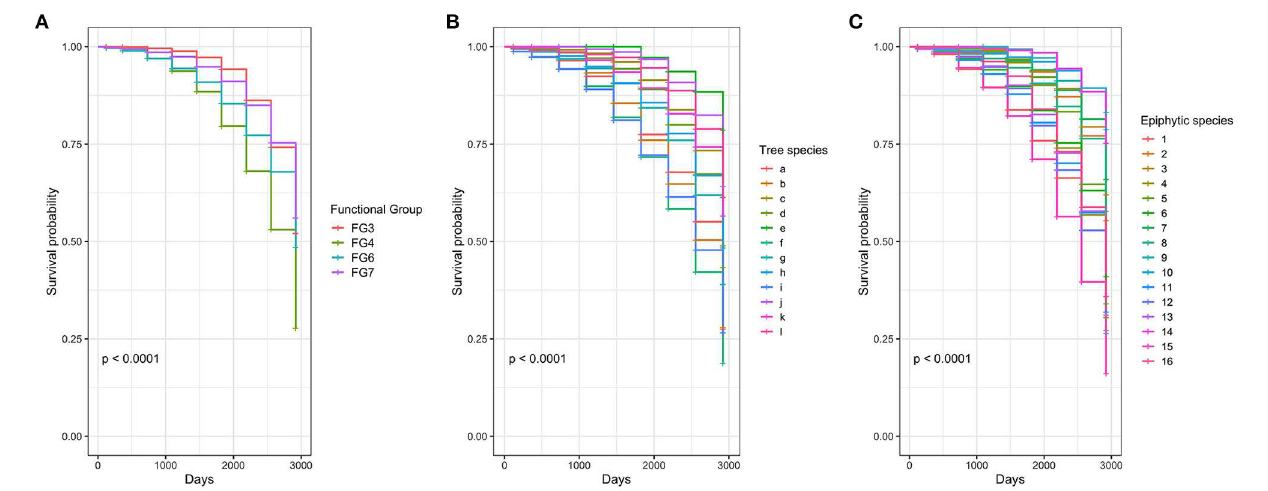
FIGURE3 Survival probability according to (A) functional groups, (B) host tree species, and (C) epiphytic species. Letters in (B) are related to a, Alchornea acutifolia Müll. Arg.; b, Chrysochlamys myrcioides Planch. and Triana; c, Clethra fagifolia Kunth; d, Clusia ducu Benth.; e, Eschweilera antioquensis Dugand and Daniel; f, Ilex laurina Kunth; g, Ladenbergia macrocarpa (Vahl) Klotzsch; h, Myrcia cf. fallax (Rich.) DC.; i, Myrcia cf. popayanensis Hieron.; j, Persea chrysophylla L.E. Kopp; k, Sciodaphyllum trianae Planch. and Linden ex Marchal; l, Vismia guianensis (Aubl.) Choisy. Numbers in (C) correspond to 1, Anthurium nigrescens ; 2, Cyrtochilum divaricatum ; 3, Dichaea morissii ; 4, Masdevallia amanda ; 5, Masdevallia platyglossa ; 6, Maxillaria brevifolia ; 7, Odontoglossum sceptrum ; 8, Oncidium cultratum ; 9, Philodendron danielii ; 10, Pleurothallis lindenii ; 11, Racinaea penlandii ; 12, Racinaea sp; 13, Racinaea subulata ; 14, Stelis crassilabia ; 15, Tillandsia archerii ; and 16, Tillandsia tetrantha .